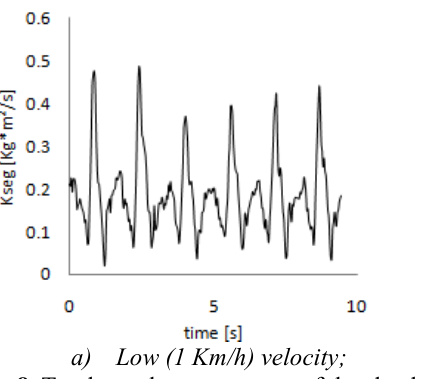
Fig. 8. Total angular momentum of the